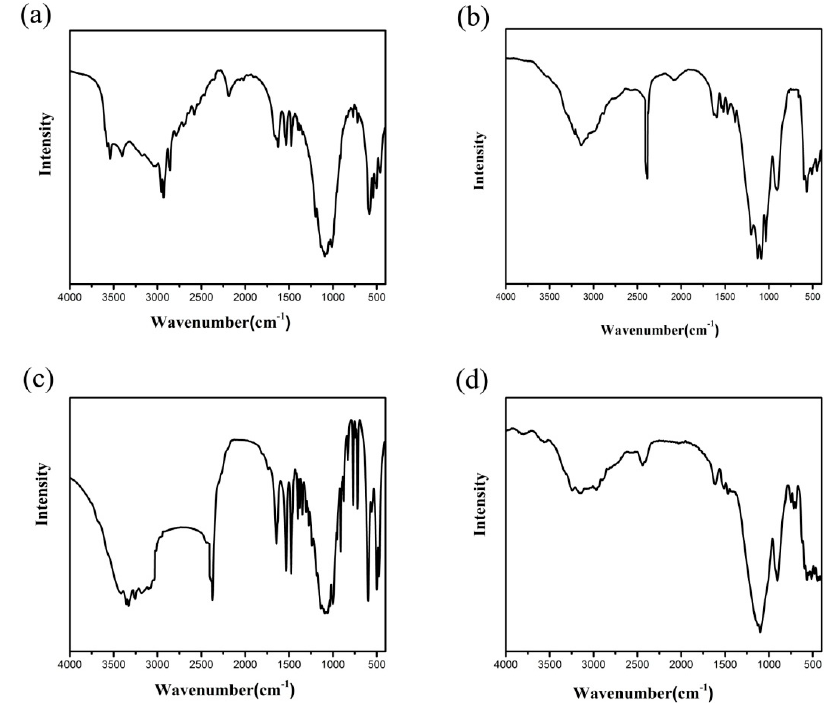
Figure 2. Simulated and experimental X-ray diffraction (XRD) patterns of compound ( a ) 1 , ( b ) 2 , ( c ) 3 , and ( d ) 4 .